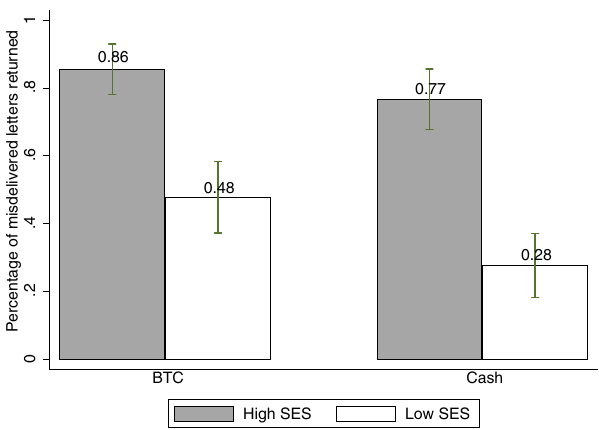
Fig. 1 The fi gure shows the percentage of envelopes returned across conditions, error bars present 95-percent con fi dence intervals ( N = 90 for each bar). BTC refers to the treatment in which the envelope contains a bank transfer card of the same value. Cash refers to the treatment in which the envelope contains a banknote. Across treatments, high SES individuals return signi fi cantly more envelopes ( N = 360, p = 0.000, two-tailed, Fisher-exact). The same applies for the BTC treatment ( N = 180, p = 0.000, two-tailed, Fisher-exact), as well as for the Cash treatment ( N = 180, p = 0.000, two-tailed,